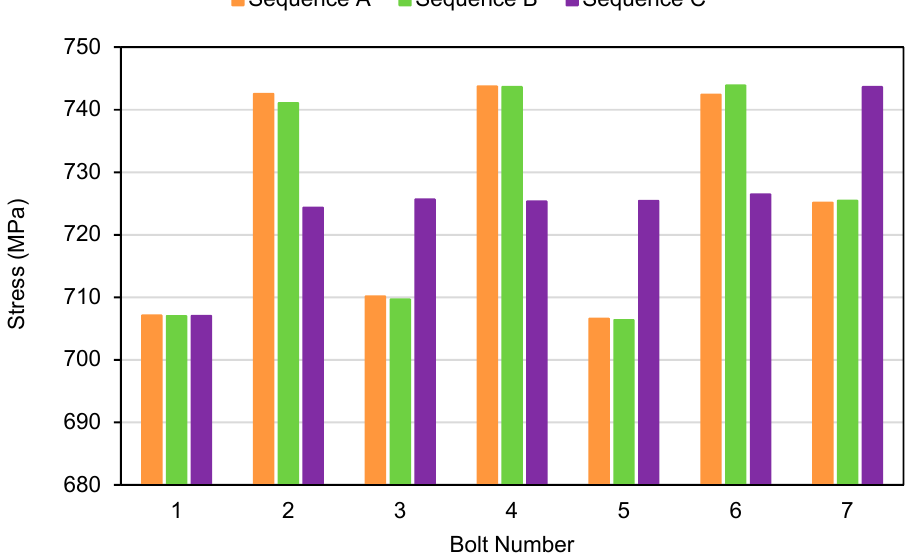
Figure 10. Fp scatter using different tightening sequences .